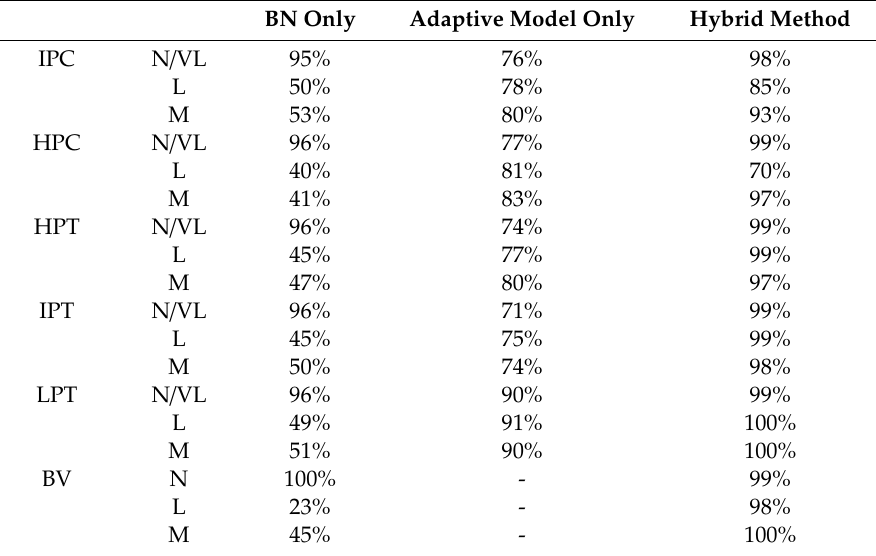
Table 8. Correctly identified faults in di ff erent flight conditions.